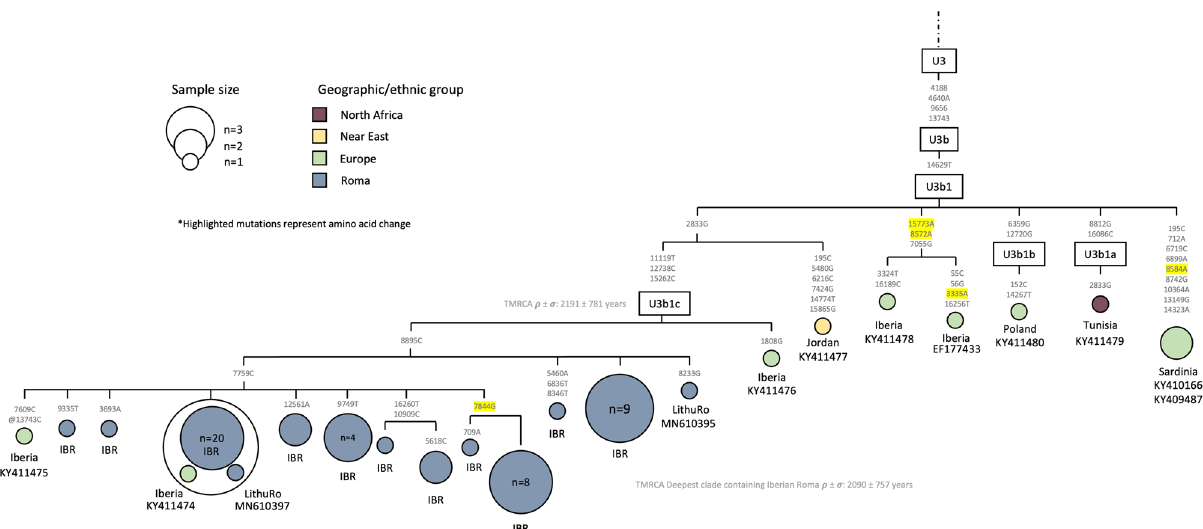
Figure 3. Maximum parsimony tree of the haplogroup U3b1c Roma mitogenomes. The mtDNA variants are indicated along the branches of the phylogenetic tree. The ‘@’ symbol represents a back mutation, and the highlighted mutations represent non-synonymous mutations. The IBR tag refers to Iberian Roma, and the ‘LithuRo’ refers to Lithuanian